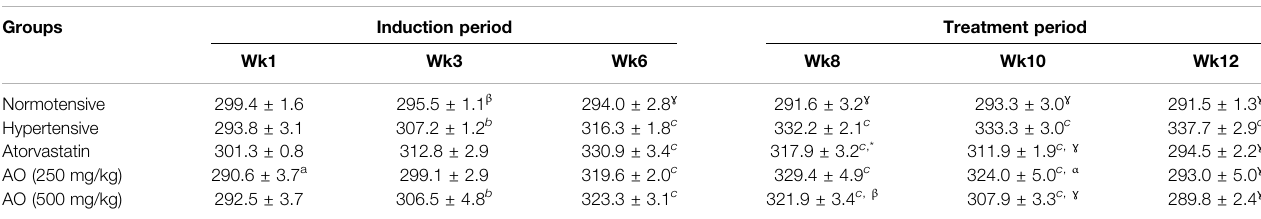
TABLE 2 | Effect of administration of Alpinia of fi cinarum (AO) on Lee index in chronic obesogenic diet-fed hypertensive rats. Groups